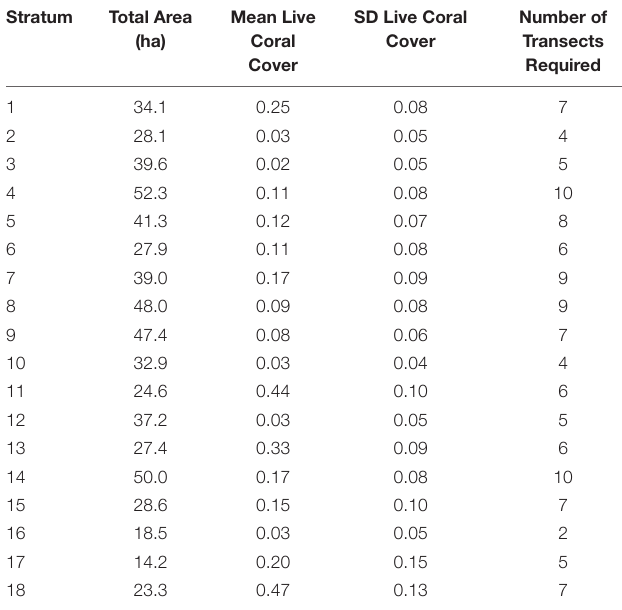
TABLE 1 | Minimum number of field sampling transects required for each of the 18 mapping reef strata based on the stratum size and within-stratum standard deviation of live coral